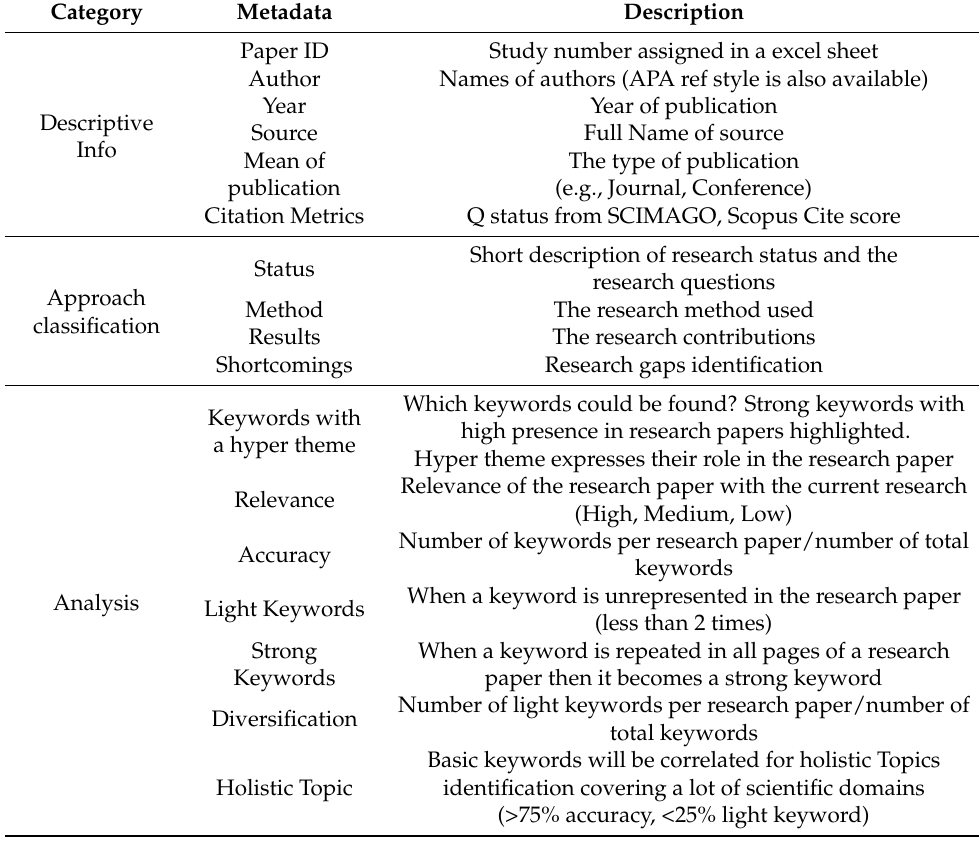
Table 1. Overview of information collected and method of